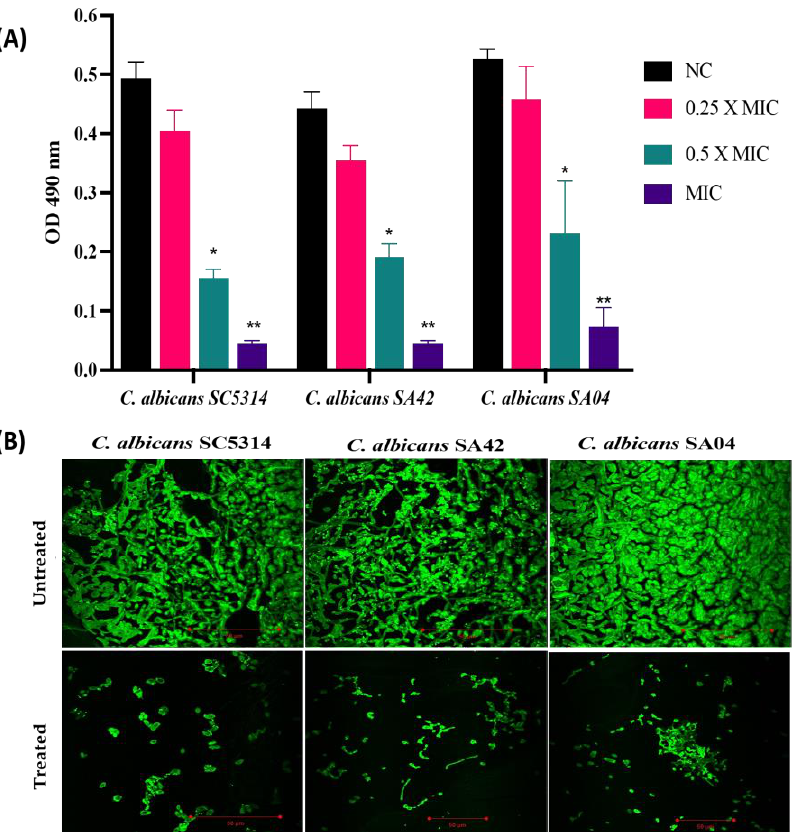
Figure 3. Antibiofilm activity of HNP against C. albicans biofilms. The figure shows the anti-biofilm potency of HNP against different strains of C. albicans , SA42 (FLC sensitive); SA04 (FLC resistant) and control strain SC5314. ( A ) The XTT assay was used to calculate the metabolic activity of cells embedded in biofilms and readings were recorded at 490 nm. NC, negative control. Statistical difference between test concentrations relative to the negative control was evaluated using Student’s unpaired two-tailed t -tests (** p value = 0.004; * p value = 0.02). ( B ) CLSM micrograph of biofilm formation in different strains of C. albicans where the biofilm matrix fluoresces green in colour due to presence of fluorescent dye Con A.